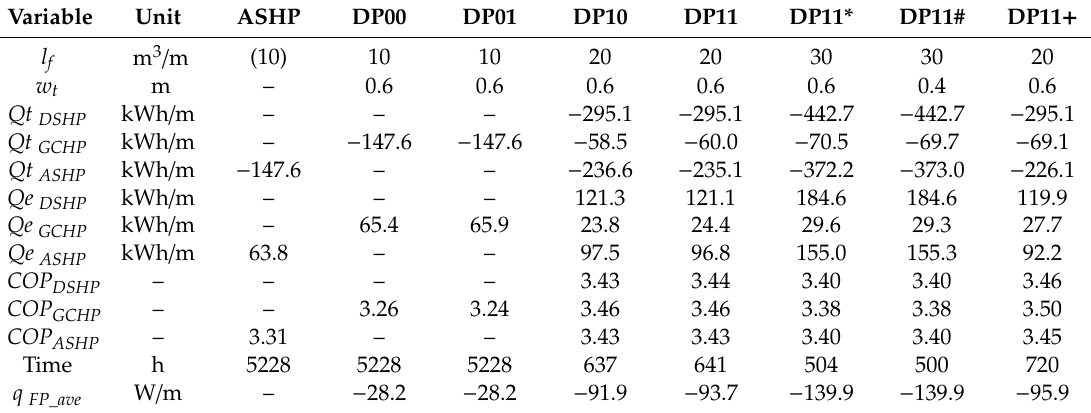
Table 3. Summary of energy performance for the di ff erent case studies in wintertime.